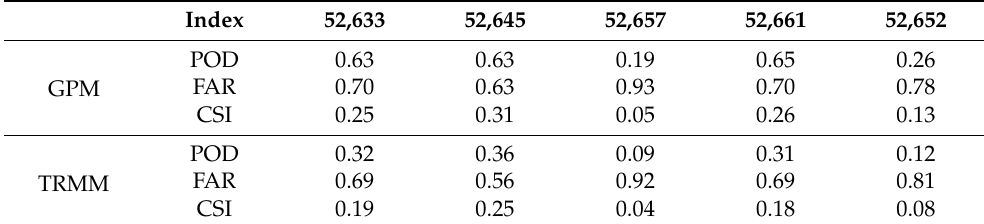
Table 7. Accuracy index of snow detection of two